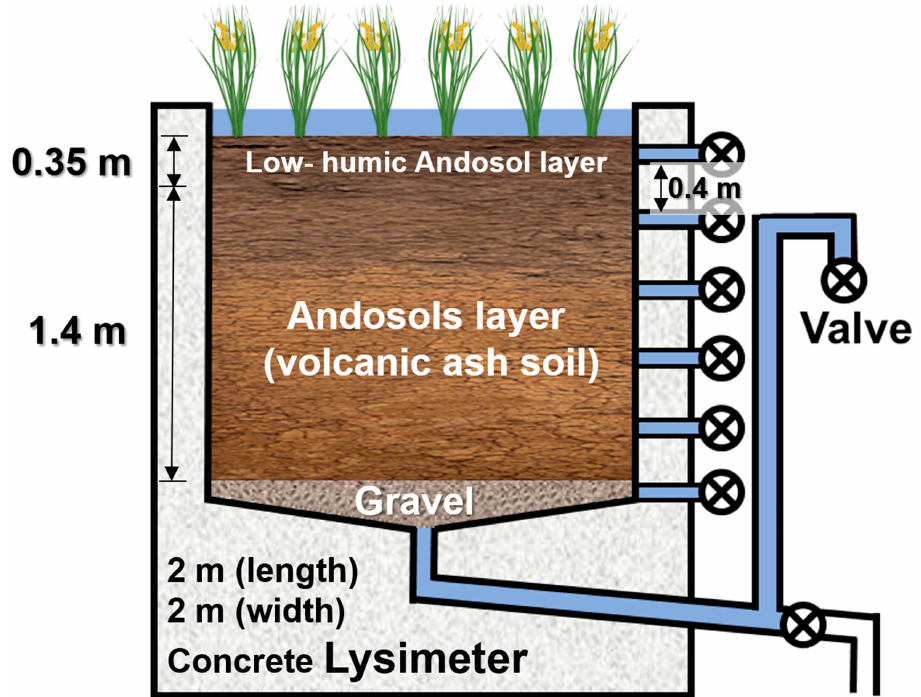
Figure 1. Schematic figure of lysimeter used for paddy cultivation in this